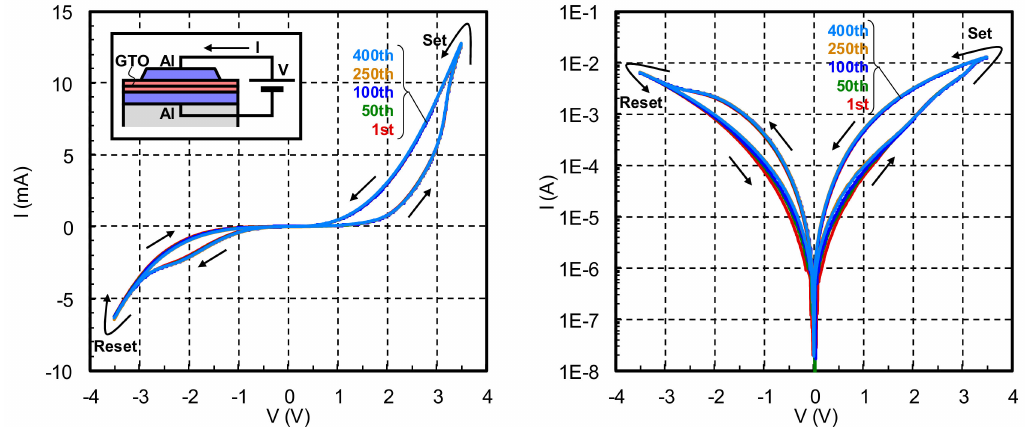
Figure 3. Memristive characteristic of the α -GTO thin film-device with double layers of di ff erent oxygen